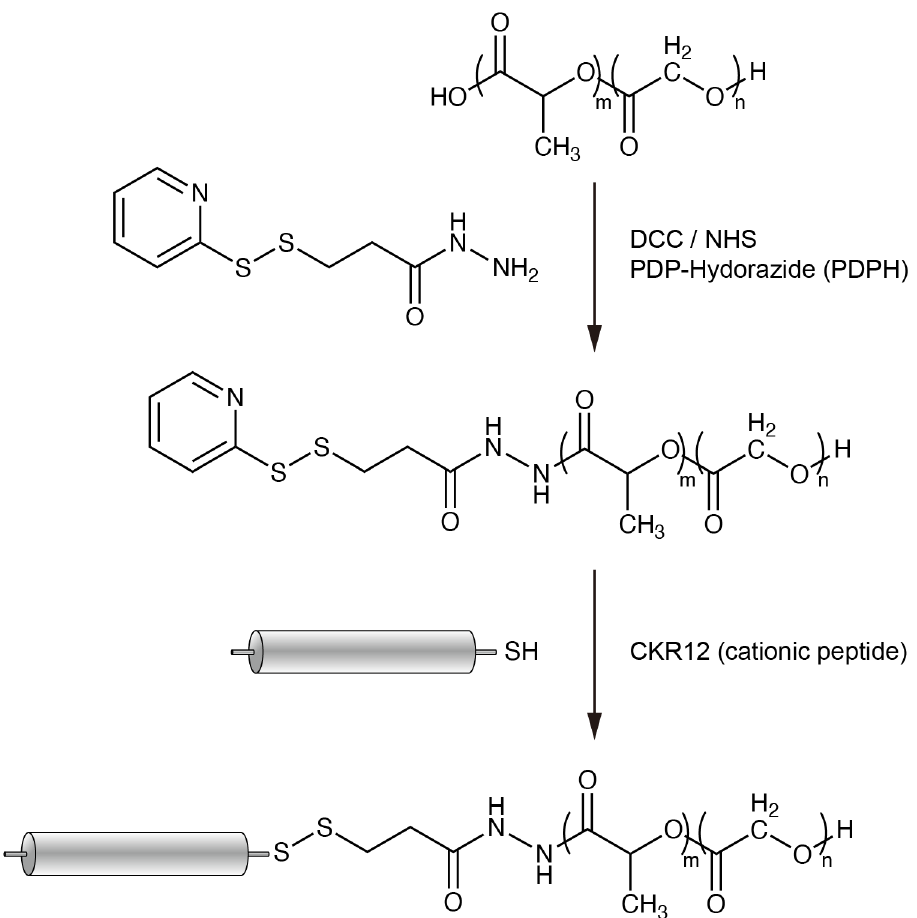
Figure 2. Summary of synthesis of CKR12-PLGA conjugate via a cleavable disulfide linkage. CKR12 is shown as a cylinder.